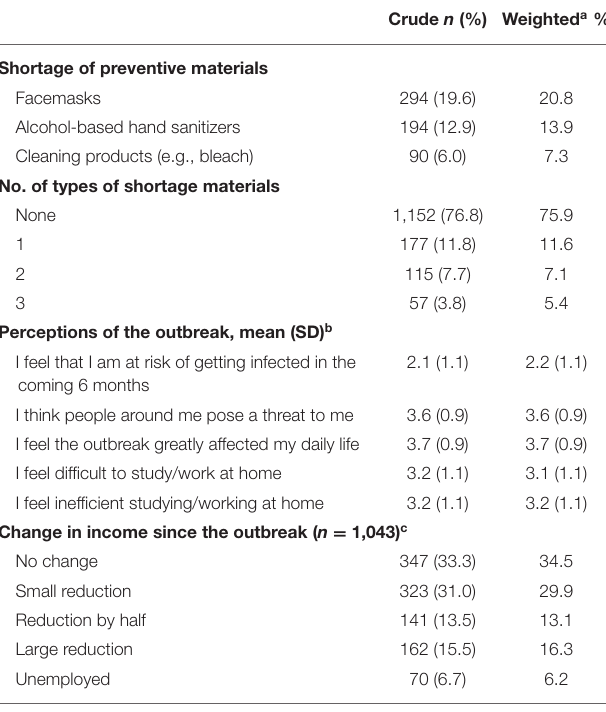
TABLE 2 | Shortage of preventive materials, perception of the outbreak, and change in income, smoking, and alcohol consumption since the